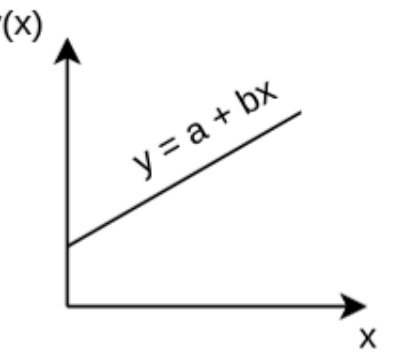
Figure 6. Linear equation for prediction (own